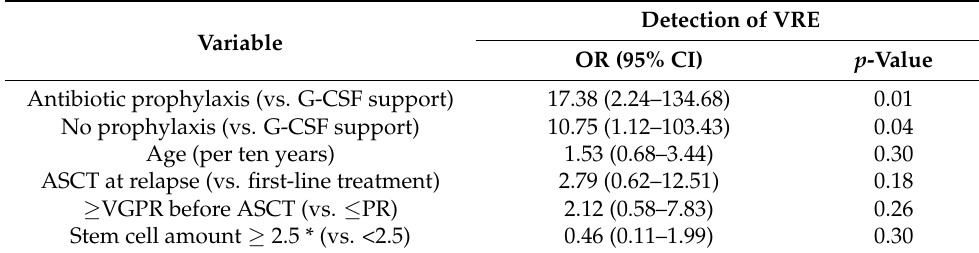
Table 5. Results of the multivariate logistic regression analysis on the impact of the anti-infective strategies (I)–(III) on the detection of vancomycin-resistant Enterococcus faecium (VRE). Detection of VRE Variable OR (95% CI) p -Value Antibiotic prophylaxis (vs. G-CSF